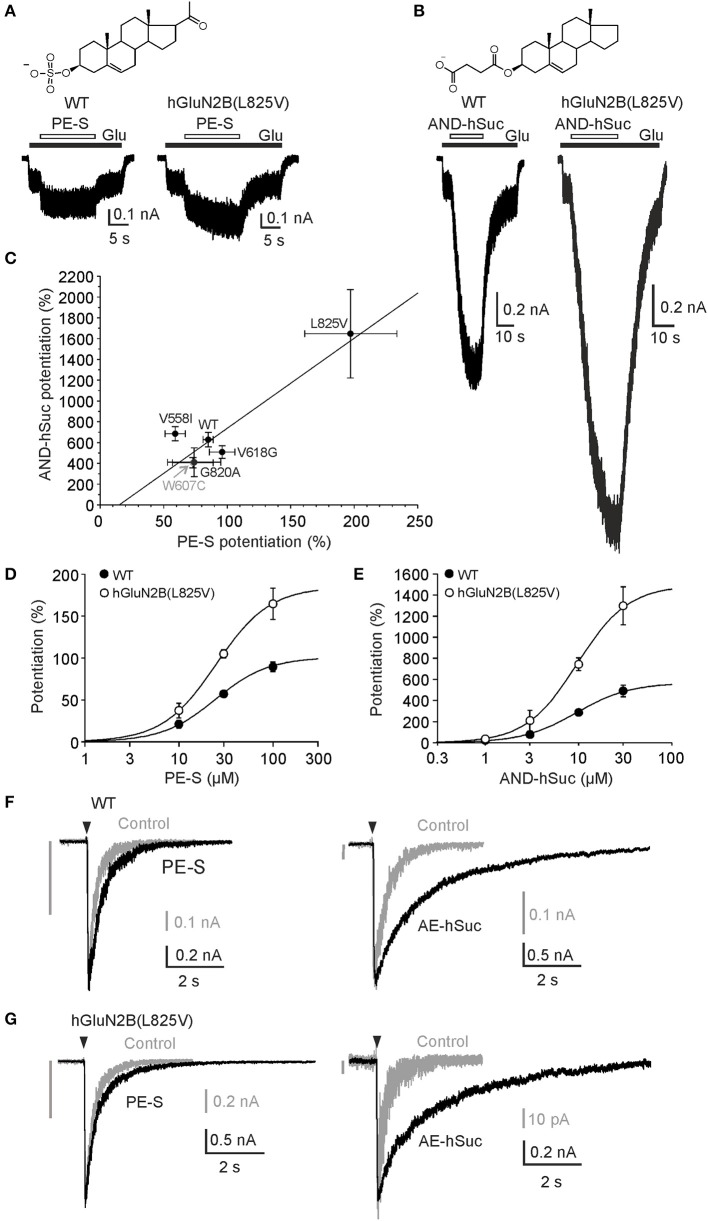
hGluN1/hGluN2B(L825V) has an enhanced sensitivity to steroids. (A) Representative responses are shown for WT and hGluN1/hGluN2B(L825V) receptors. PE-S (100 μM) (A) and AND-hSuc (30 μM) (B) potentiated the WT receptor responses induced by co-application with 1 μM glutamate in the continuous presence of 30 μM glycine to a different extent (by 85% and 575%, respectively). Both steroids potentiated responses induced in hGluN1/hGluN2B(L825V) receptors ~2-fold more than in WT receptors. Structure of PE-S (A) and AND-hSuc (B). (C) Graph shows relative PE-S (100 μM) potentiation ± SEM (n = 5–31) plotted vs. that induced by AND-hSuc (30 μM) ± SEM in the WT and in mutated receptors. Data were fit by a linear regression (Correlation coefficient r = 0.928; p = 0.00764). Concentration dependency for PE-S (D) and AND-hSuc (E) induced potentiation of WT and hGluN1/hGluN2B(L825V) receptors activated by 1 μM glutamate in the continuous presence of 30 μM glycine. Parameters of the fit (see Equation 9) were for the WT receptors: PE-S induced relative maximal potentiation Imax = 101 ± 9%; EC50 = 24.3 ± 1.8 μM with h = 1.54 ± 0.08 (n = 7); AND-hSuc Imax = 570 ± 57%; EC50 = 9.5 ± 1.0 μM; h = 1.50 ± 0.16 (n = 6). In hGluN1/hGluN2B(L825V) receptors: PE-S induced Imax = 185 ± 50% (p = 0.030 compared to WT); EC50 = 24.8 ± 1.2 μM (p = 0.842 compared to WT) with h = 1.52 ± 0.12 (n = 5); AND-hSuc Imax = 1492 ± 514% (p = 0.030 compared to WT); EC50 = 9.6 ± 2.3 μM (p = 0.961 compared to WT) with h = 1.58 ± 0.36 (n = 6). (F,G) Normalized representative current responses of WT and hGluN1/hGluN2B(L825V) receptors induced by brief (5 ms) application of 1 mM glutamate made in the ECS (Control, gray) and in the presence of PE-S (100 μM) or AND-hSuc (30 μM) following steroid pre-application for (>30 s). The vertical gray bar indicates the amplitude of the control response at the same amplitude scale as that recorded in the presence of steroid. See Table 3 for values and statistics on the steroid effect.